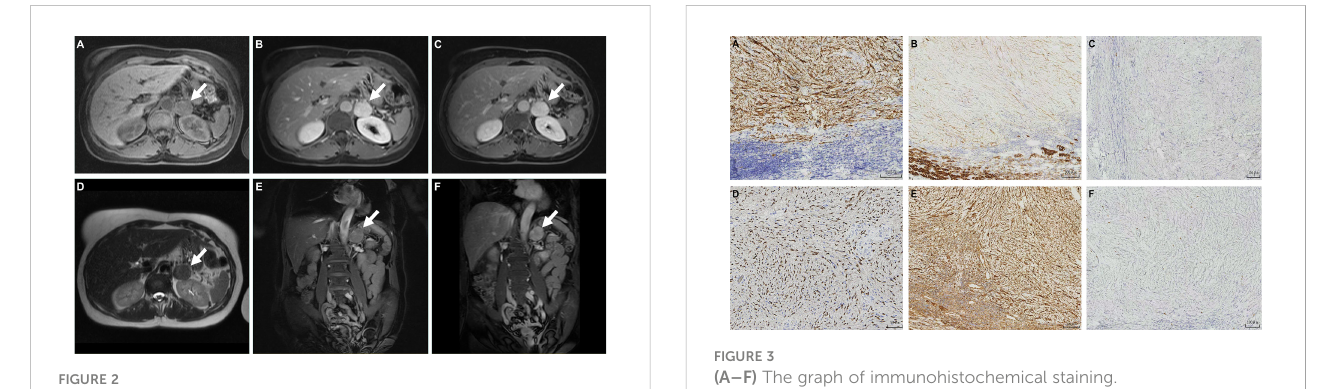
FIGURE 2 (A – F) MRI of the patient before surgery.